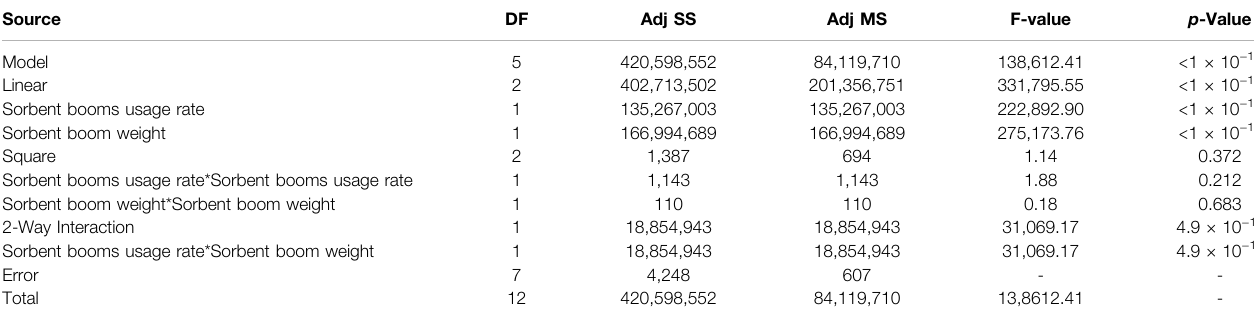
TABLE 7 | Analysis of variance for estimation of total solid waste based on sorbent booms usage rate (m/12 h) and sorbent boom weight